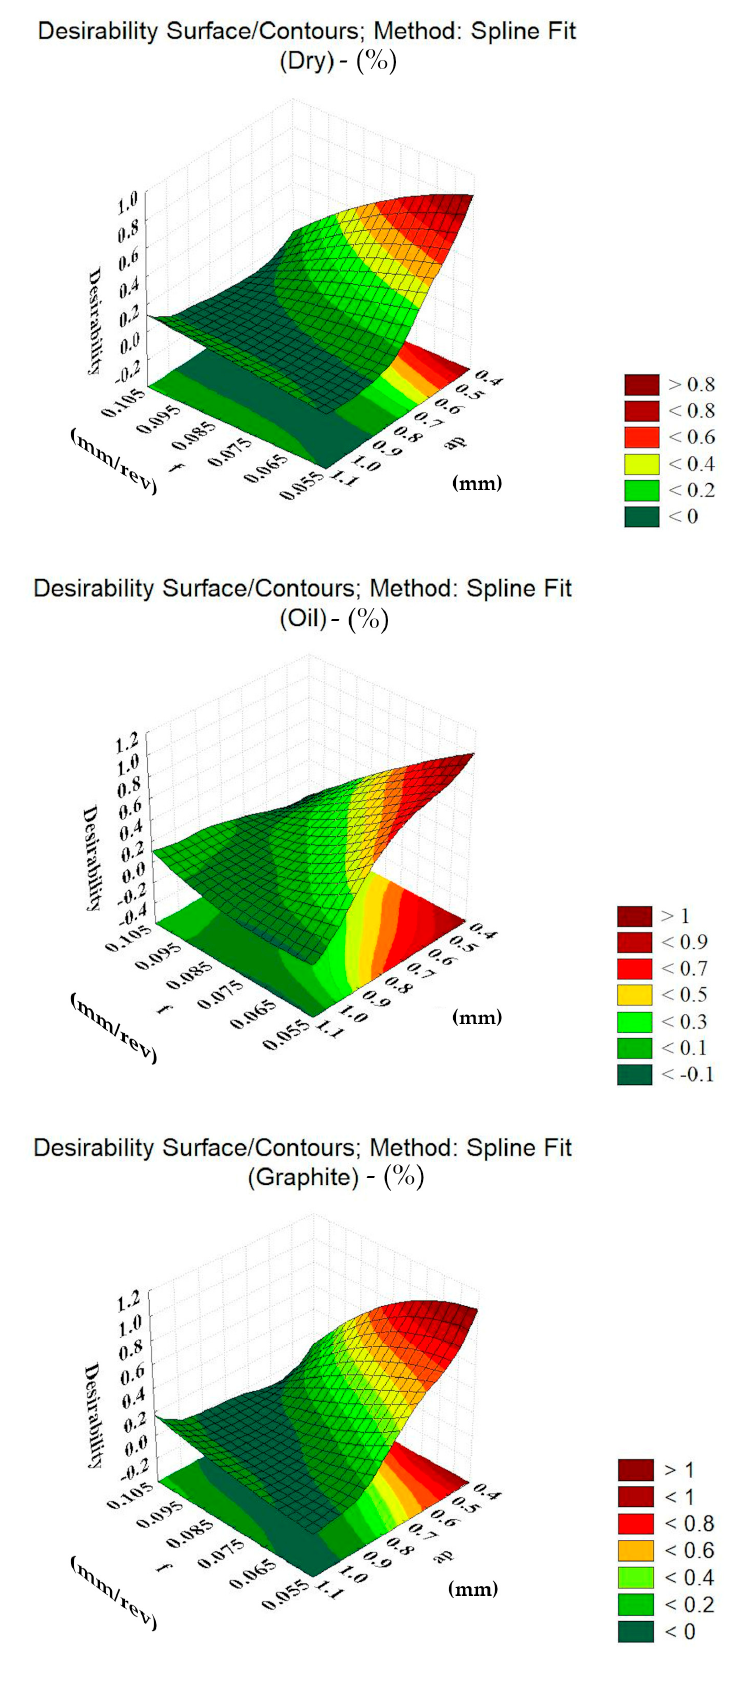
Figure 21. Desirability response surfaces.